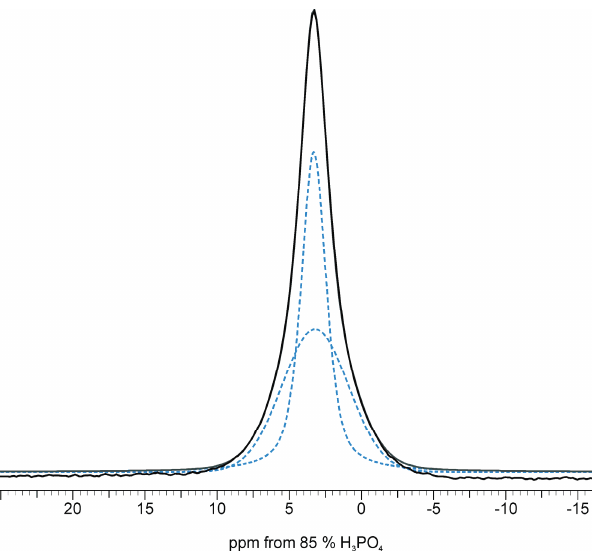
Figure 3. Representative peak fittings of the 31 P CP NMR spectrum for the HA 300 -1.2SeO 3